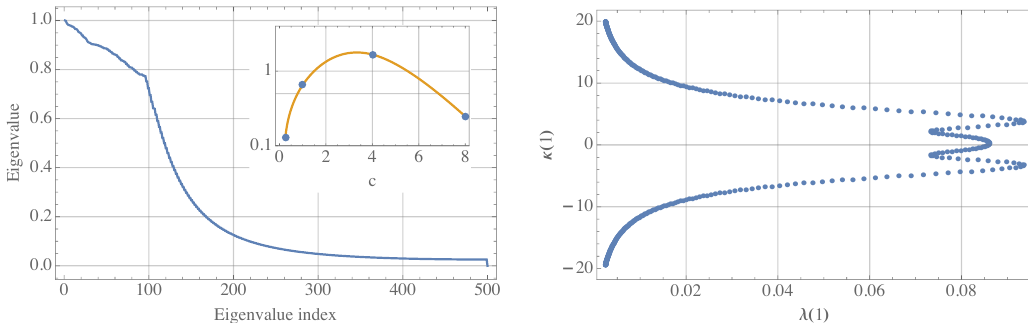
Figure 3: Spectra of the diffusion operators for a thermal state with c = 1 and T = 1. Left panel: Distribution of 500 eigenvalues of ˜D . The eigenvalues are normalized to the largest eigenvalue (about 0.19) and ordered from maximal to minimal. The cusps are the artefact of this ordering and appear when the degeneracy of the eigenvalues changes. The inset shows the dependence of the trace of ˜D on the interaction strength in the BEC-quench saddle-point state. Right panel: Distribution of 500 eigenvalues z of D for k = 1. The eigenvalues form a complex spectral curve. Each point k , ω k plotted correspond to a single eigenstate and eigenstates can be labeled uniquely by its imaginary part κ ( 1 )